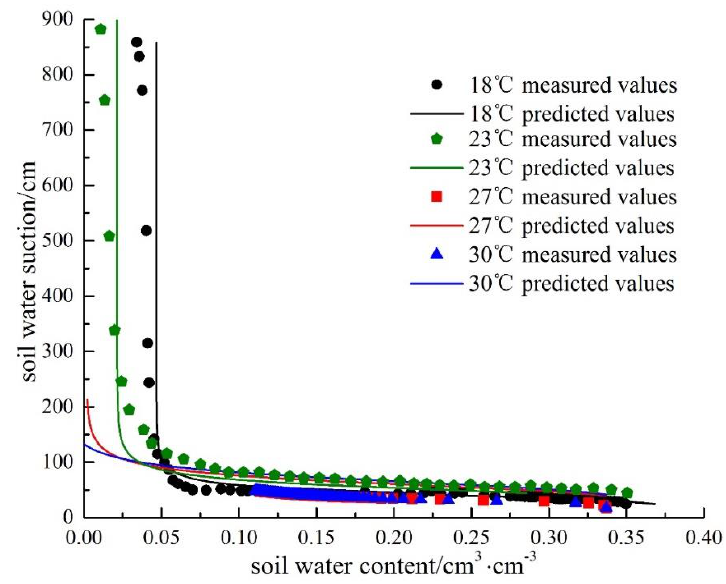
Figure 8. Predicted and the measured values for the soil-water characteristic curve (SWCC).